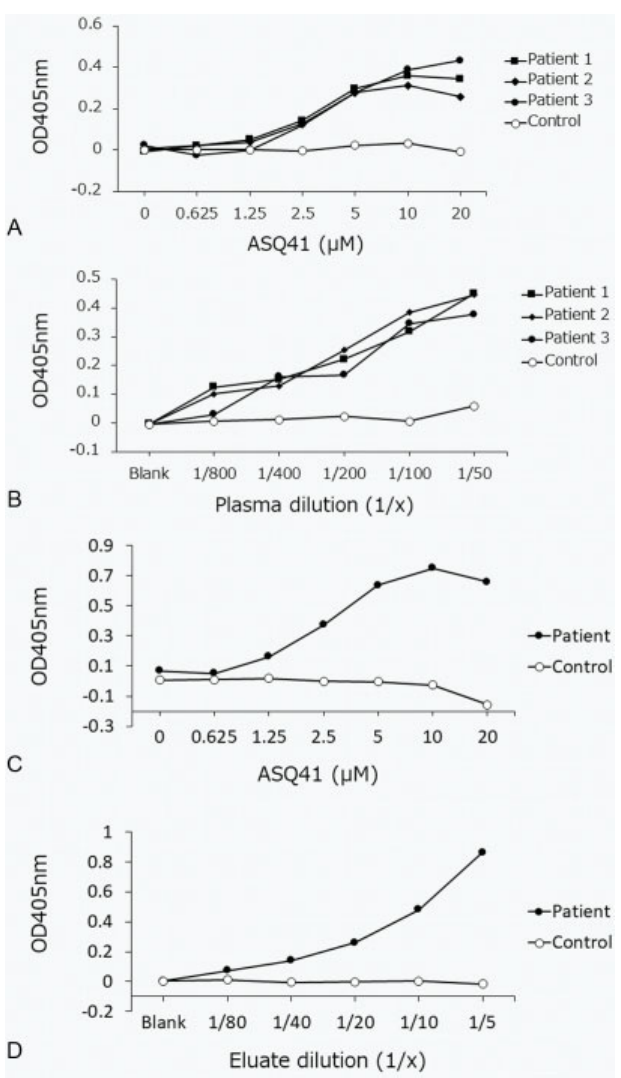
Fig. 3. Dose-dependentbindingofautoantibodiestothesyntheticpeptideASQ41.( A )Aminoplatewellswerecoatedwithincreasingconcentrations(35µL of0,0.625,1.25,2.5,5.0,10,and20 μ Msolutions)ofASQ41orthescramblepeptideCRG41.Wethenappliedanti-ASQ41-positivepatientplasmasamplesor normal control plasma (1:100), followed by an alkaline-phosphatase-conjugated secondary antibody. The absorption was evaluated at 405nm. Then, we subtracted the OD value of the scramble peptide CRG41 from the OD value of the ASQ41 peptide. ( B ) Amino plate wells were coated with ASQ41 or the scramblepeptideCRG41(30 μ Lofa10 μ Msolution).Wethenappliedseveraldilutions(1:800, 1:400,1:200,1:100,and1:50) of anti-ASQ41-positivepatient plasma samples or normal control plasma, followed by an alkaline-phosphatase-conjugated secondary antibody. The absorption was evaluated at 405nm. Then,wesubtractedtheODvalueofthescramblepeptideCRG41fromtheODvalueoftheASQ41peptide.( C )Aminoplatewellswerecoatedwithincreasing concentrations (50 µL of 0, 0.625, 1.25, 2.5, 5.0, 10, and 20 μ M solutions) of ASQ41 or the scramble peptide CRG41. We then applied the eluate from the ASQ41-af fi nity column that contained autoantibodies to ASQ41 that were puri fi ed from anti-ASQ41-positive patient plasma or normal control plasma. Wethenappliedanalkaline-phosphatase-conjugatedsecondaryantibody.Theabsorptionwasevaluatedat405nm.Then,wesubtractedtheODvalueof the scramblepeptideCRG41fromtheODvalueof theASQ41peptide.( D )AminoplatewellswerecoatedwithASQ41or thescramblepeptideCRG41(50 μ Lofa 10 μ M solution). We then applied several dilutions (1:80, 1:40, 1:20, 1:10, and 1:5) of the eluate, which contained puri fi ed antibodies to ASQ41 from